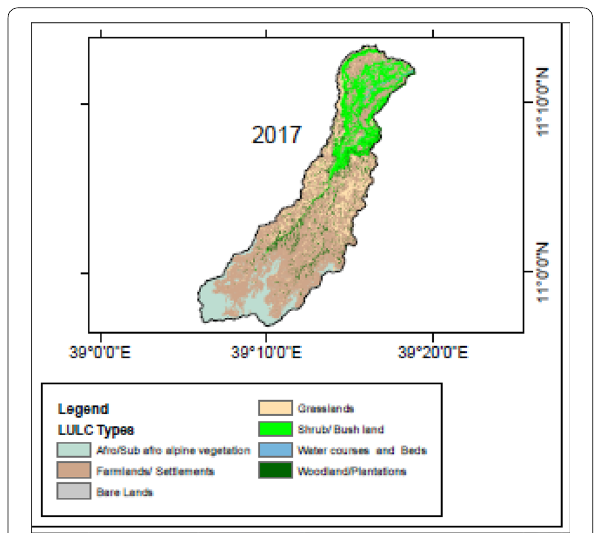
Fig. 10 Land use and land cover map of Gedalas watershed